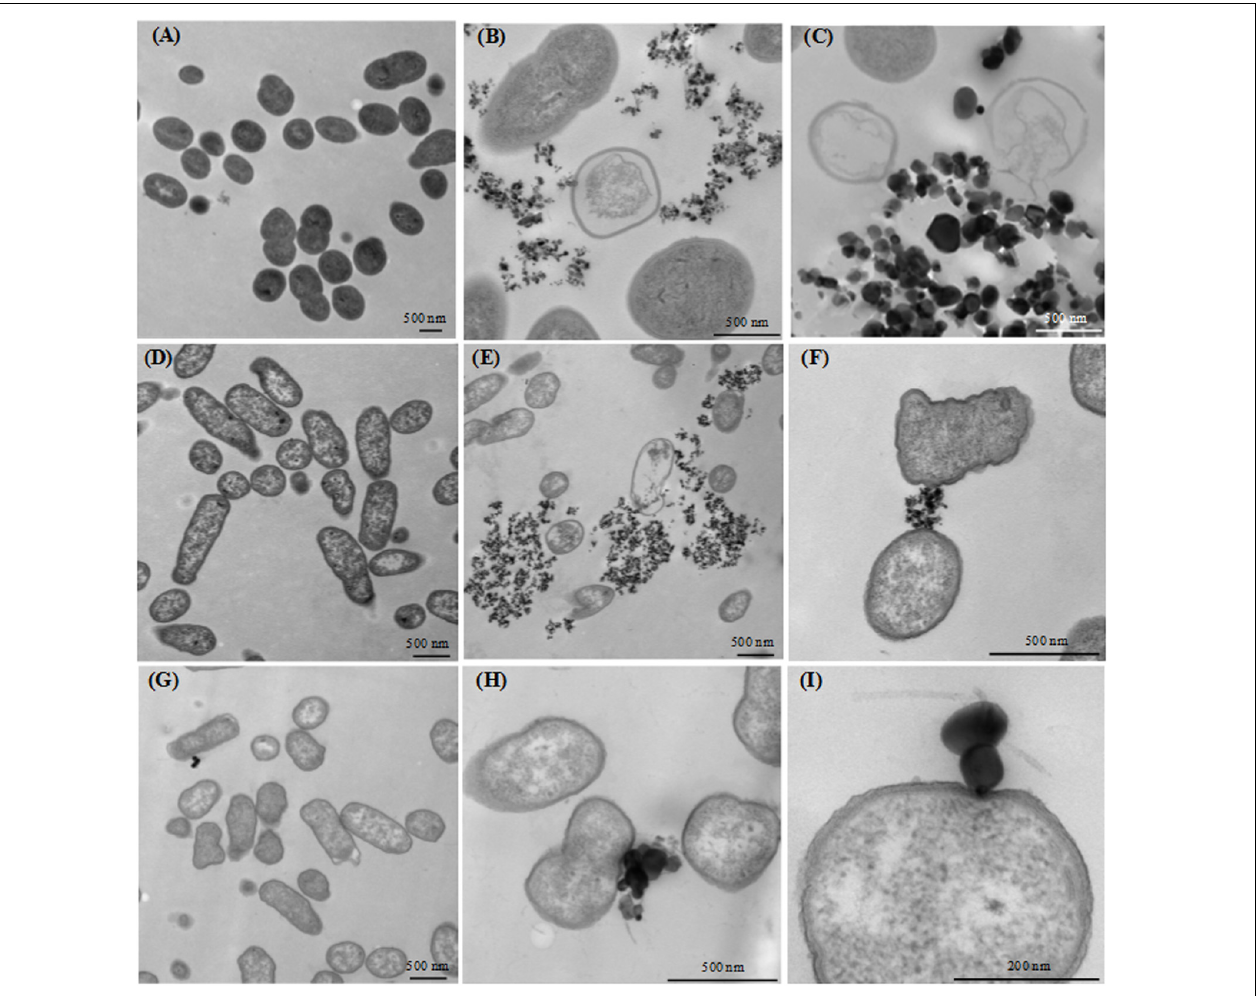
FIGURE 5 | Transmission electron microscopy (TEM) images of bacterial cells after TiO 2 exposure. (A–C) growing L. lactis IBB477 bacterial cells: (A) non-exposed, (B) exposed to P25-A 320 µ g/mL and (C) exposed to E171-D 320 µ g/mL; (D–I) growing E. coli K12 MG1655 bacterial cells: (D) non-exposed, (E) exposed to P25-A 320 µ g/mL, (F) exposed to P25-D 320 µ g/mL, (G,H) exposed to E171-A 320 µ g/mL and (I) exposed to E171-D 320 µ